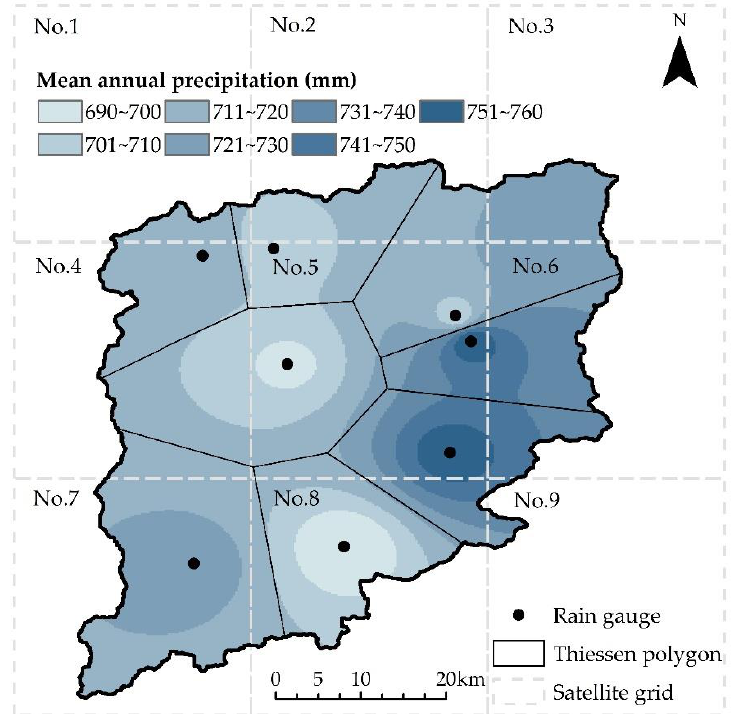
Figure 2. Intersection of Thiessen polygons (black lines) with satellite grids (dashed lines, 0.25° × 0.25°, No.1–No.9). The grayish-blue filling indicates the spatial distribution of mean annual precipitation of gauge observations.